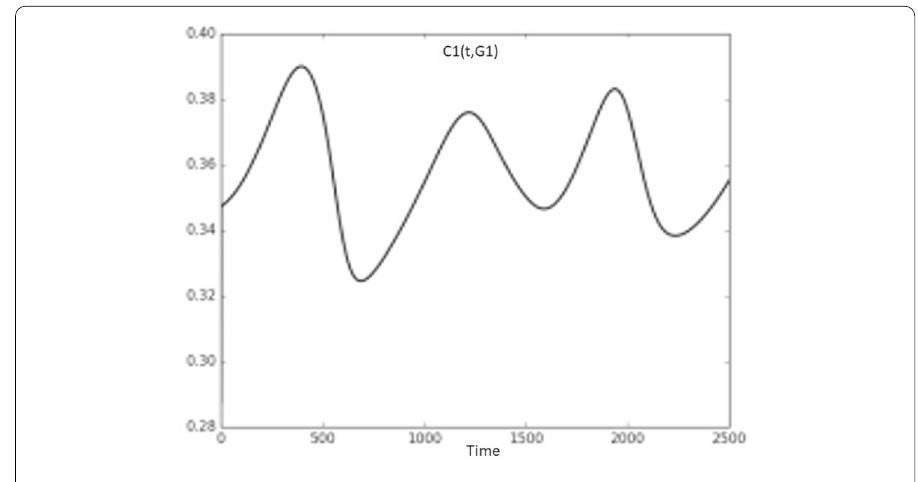
Fig. 29 The first temporal weight by the Galerkin projection upon (cid:9) : c 1 ( t,G 1 )